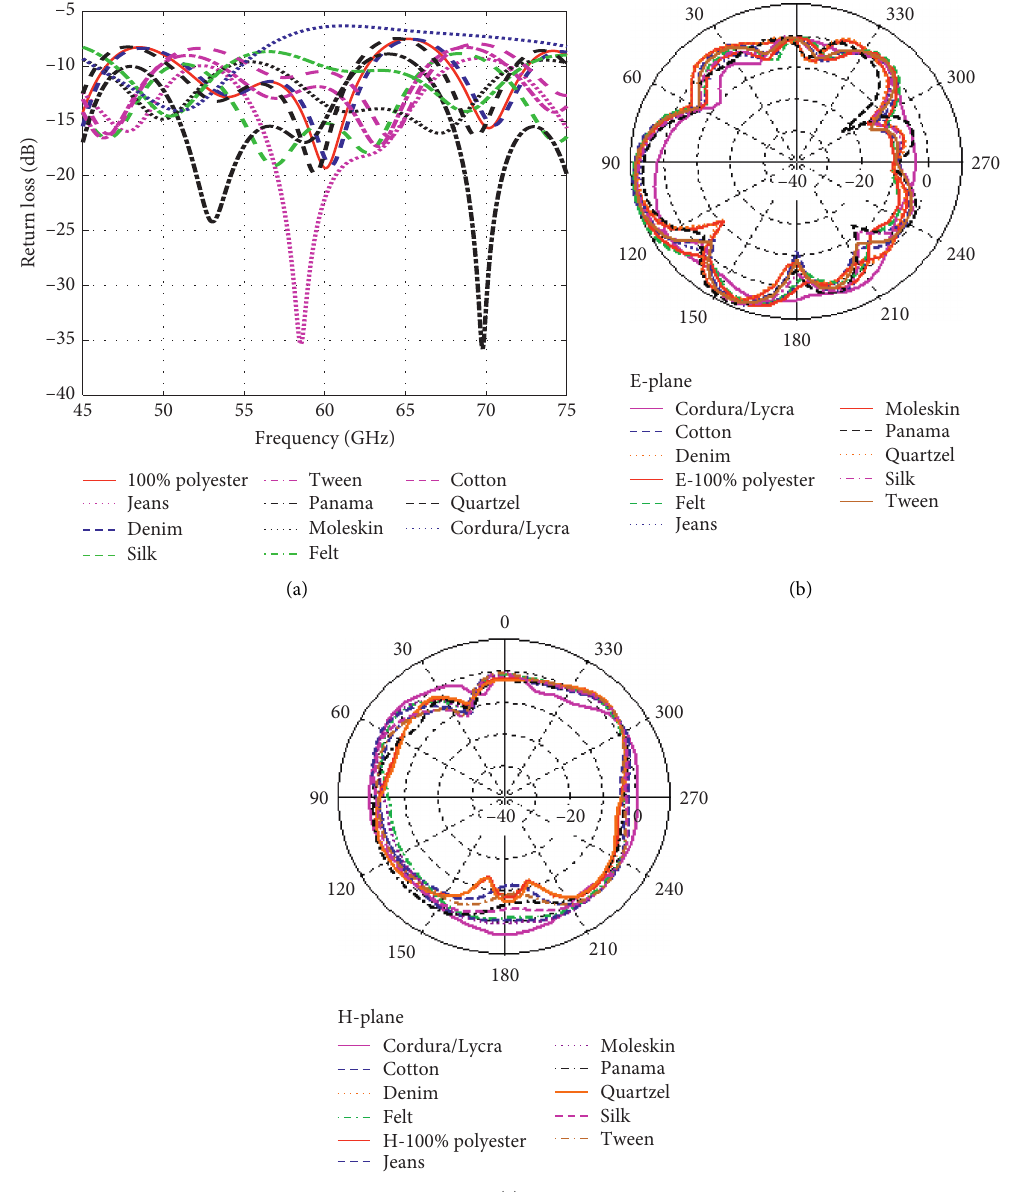
Figure 10: Comparison of antenna performance for different textile substrates in free-space (a) return loss (b) E-plane radiation patterns (c) H-plane radiation